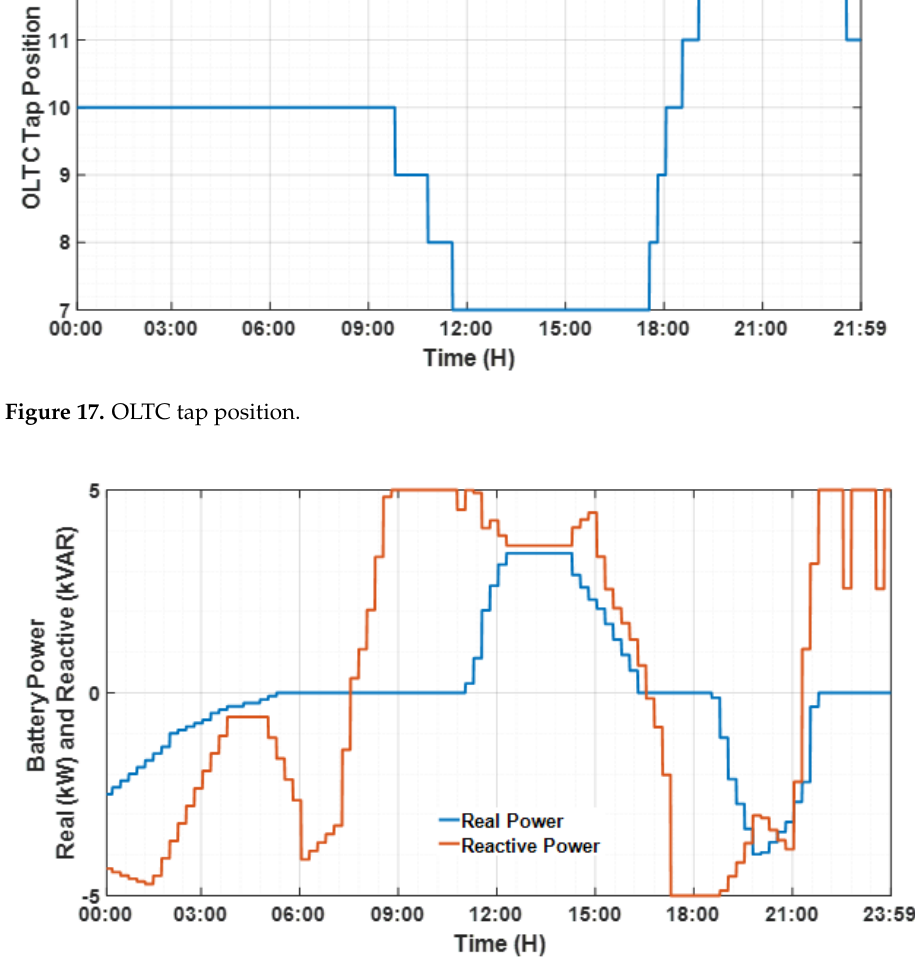
Figure 18. Real and reactive power from EV